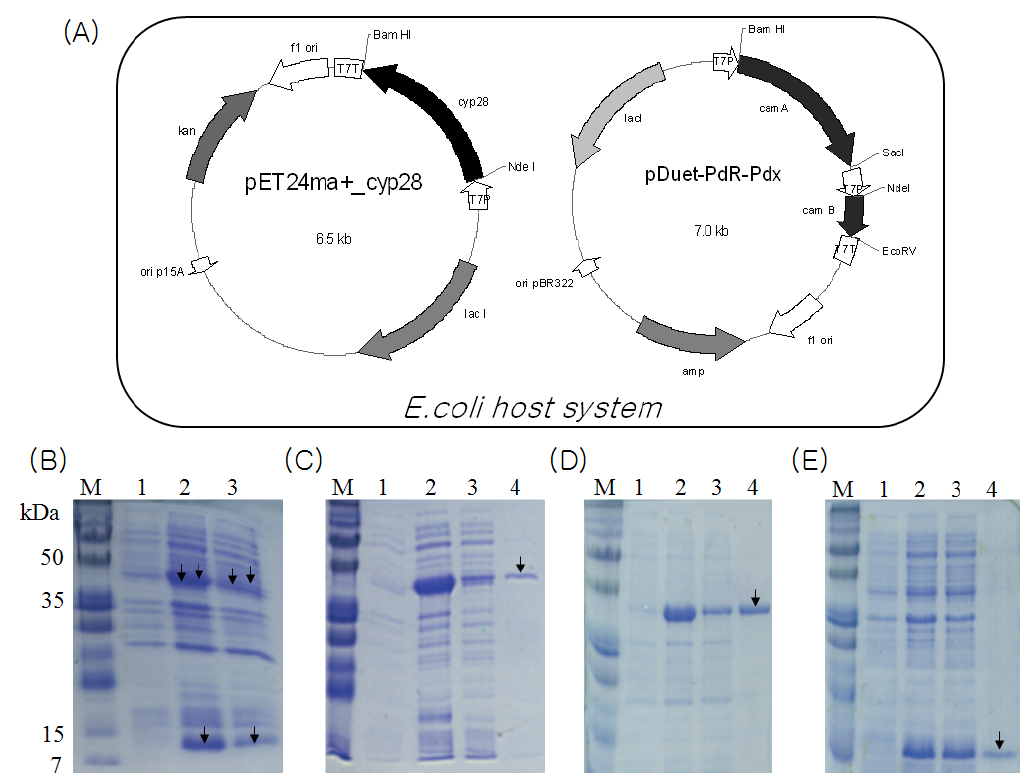
Figure 2. ( A ) A schematic CYP105D7 and PdR/Pdx coexpression plasmids in E. coli system. CYP105D7 is encoded on the 6.5 kb constructed pET24ma+_cyp28 under control of a T7 promoter with IPTG induction system. The 7.0 kb plasmid pDuet-PdR-Pdx contains two copies of the T7 promoter and a transcription terminator; ( B ) SDS-PAGE 13% gel showing the coexpressed proteins of CYP105D7 and PdR/Pdx. lane M, protein marker; lane 1, before induction form of CYP105D7 and PdR/Pdx; lane 2, total form of CYP105D7 and PdR/Pdx; lane 3, soluble form of CYP105D7 and PdR/Pdx; ( C ) SDS-PAGE 12% gel showing CYP105D7 with His-tag. M, protein marker; lane 1, before induction form of CYP105D7; lane 2, total form of CYP105D7; lane 3, soluble form of CYP105D7; lane 4, His-Tag form of CYP105D7; ( D ) SDS-PAGE 12% gel showing PdR with His-tag. M, protein marker; lane 1, before induction form of PdR; lane 2, total form of PdR; lane 3, soluble form of PdR; lane 4, His-Tag form of PdR; ( E ) SDS-PAGE 13% gel showing Pdx with His-tag. M, protein marker; lane 1, before induction form of Pdx; lane 2, total form of Pdx; lane 3, soluble form of Pdx; lane 4, His-Tag form of Pdx. Arrow represents protein,